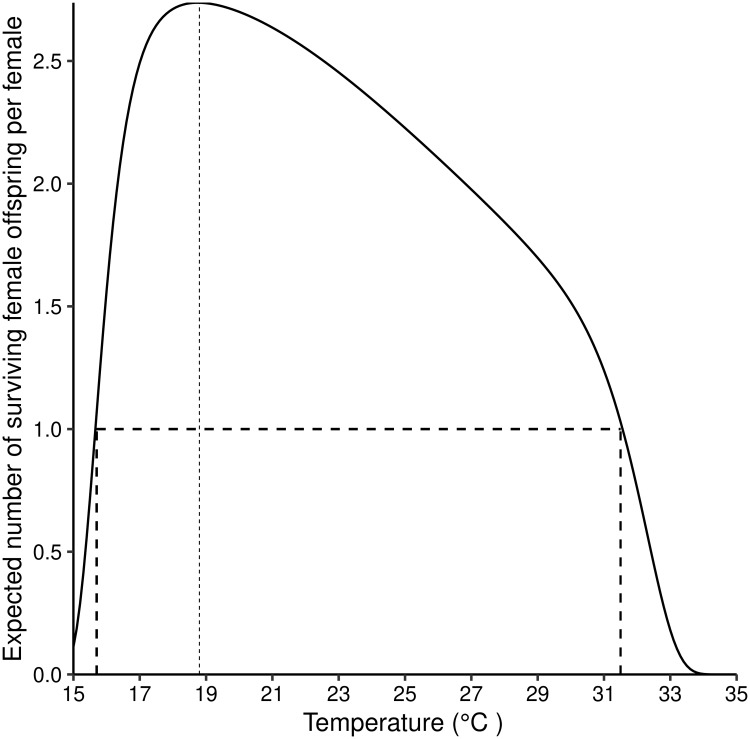
Expected number of surviving female offspring per adult female G. m. morsitans for different temperatures (15°C–35°C).Eq (5) solved for different values of temperature. The fine vertical dotted line at about 19°C indicates the temperature at which a female produces the greatest number of surviving daughters. The dashed vertical lines just below 15°C and just above 31°C, respectively, indicate the temperatures below and above which a female produces fewer than one surviving daughter.